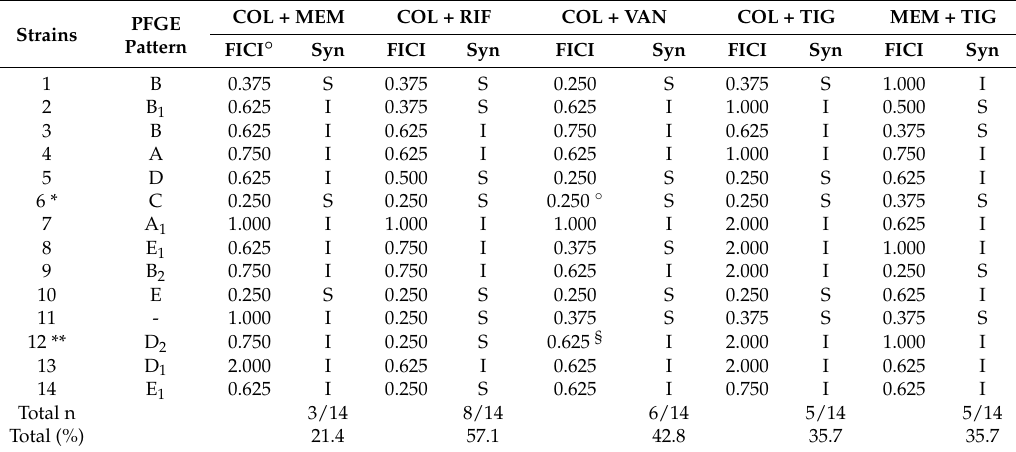
Table 3. Synergism of different combinations against CR-Ab throughout checkerboard method. The 14 clinical isolated as listed in Table 1 were